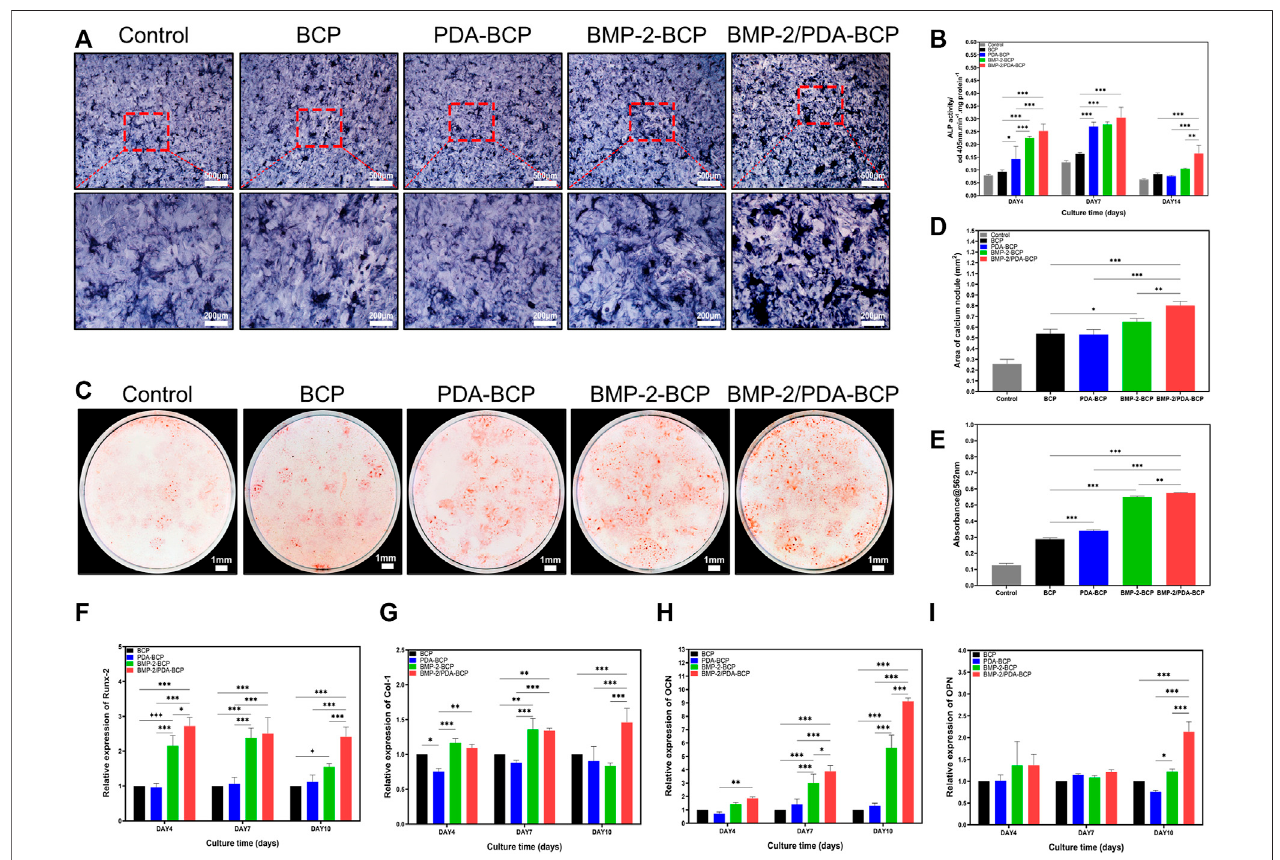
FIGURE 5 | Effect of scaffolds on the osteogenic differentiation of BMSCs in vitro . (A) Representative microscopic images of ALP staining results for BMSCs after cultivation with scaffolds for 10 d. Scale bars = 500 μ m, 200 μ m. (B) The ALP activity was normalized by the total cell protein (OD 560 nm) of each sample at Days 4, 7, and 14 after seeding. (C) Representative digital images of alizarin red S staining of cells cultured in osteoinductive conditional medium for 21 d. Scale bars = 1 mm. (D) Quanti fi cationofalizarinredSstainingareaonvariousscaffoldsfrom Figure5C byImageJsoftware. (E) ResultsofquantifyingtheamountofalizarinredS.Dataare presentedasthemean±S.D.** p < 0.01,*** p < 0.001.qRT-PCRofosteogenicgeneexpressioninBMSCsat4,7,and10 dafterseedingontoBCP,PDA-BCP,BMP-2- BCP, and BMP-2/PDA-BCP scaffolds under osteoinductive conditions, including (F) Runx-2, (G) Col-1, (H) OCN, and (I) OPN. * p < 0.05, ** p < 0.01 and *** p <